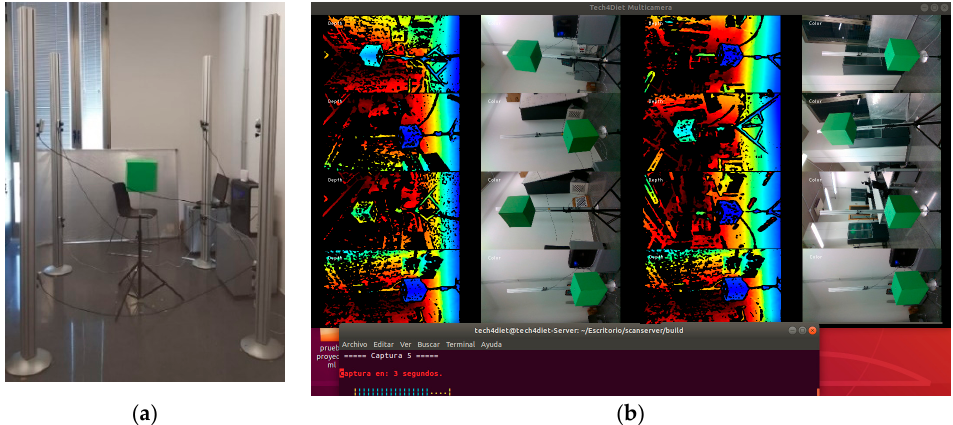
Figure 2. ( a ) Experimental set-up of eight RGB-D cameras. ( b ) Acquisition results for the eight cameras (color and depth images). The green cube was used for extrinsic